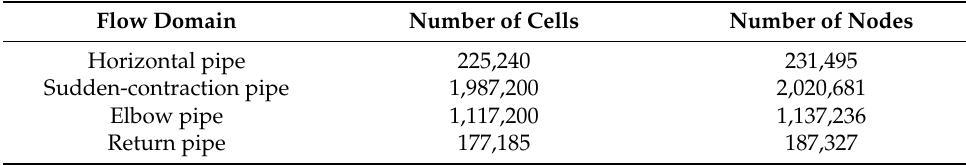
Table 1. The cells and nodes of flow domains.